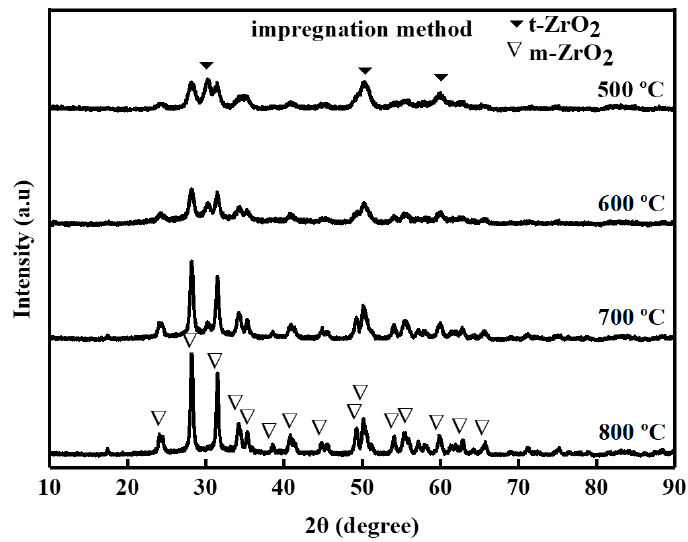
Figure 6. XRD pattern of MgZr-i catalysts formed by impregnation method.